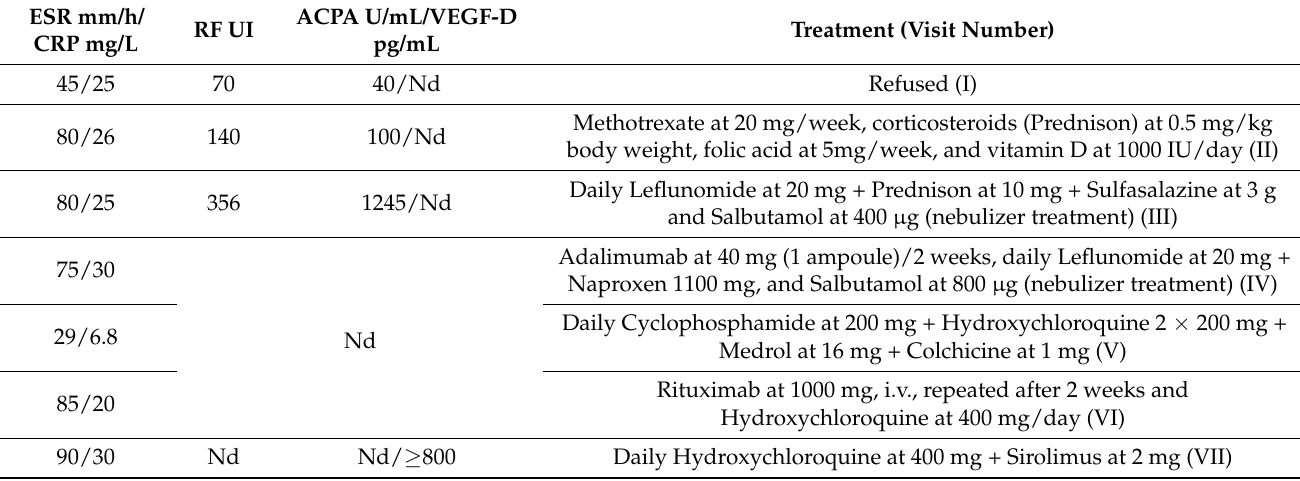
Table 2. Summary of the patient’s biological markers of disease in dynamics and the changes in the treatment